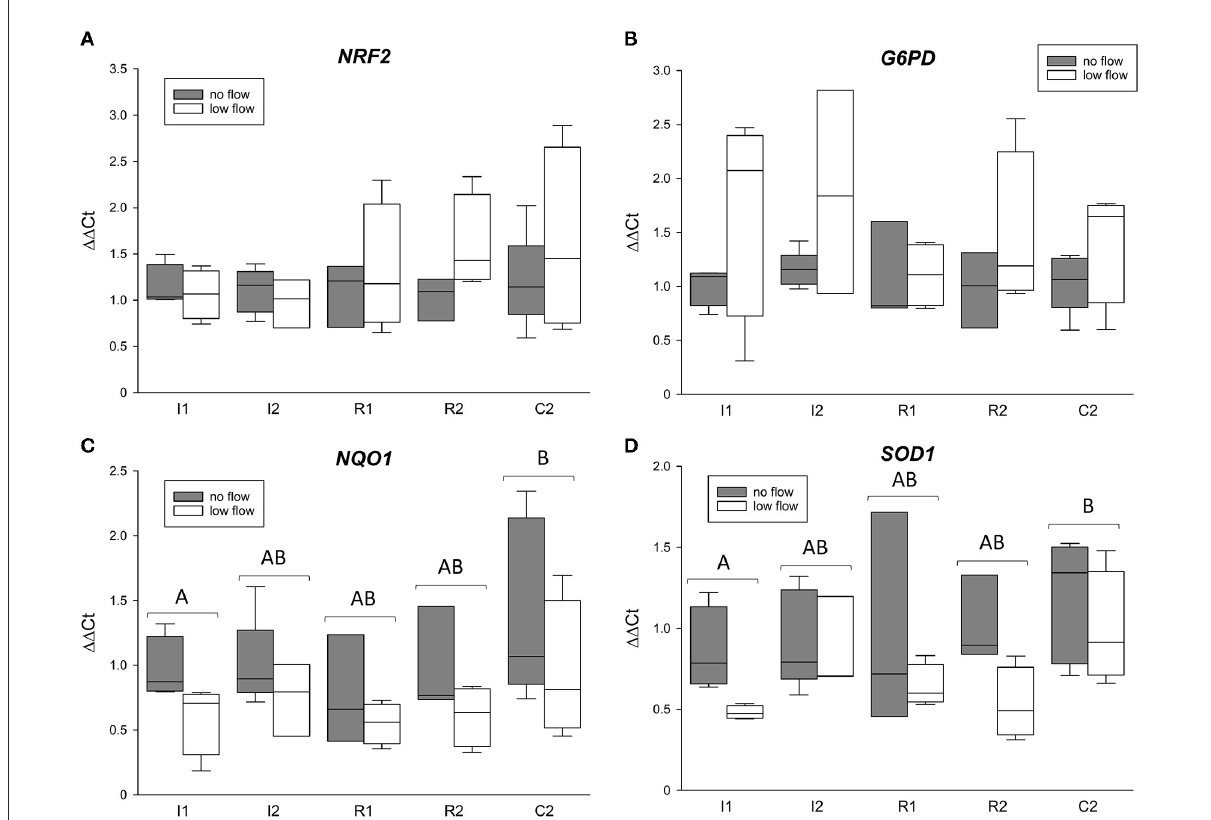
FIGURE2 mRNA expression of NRF2 (A) and its target genes G6PD (B) , NQO1 (C) , and SOD1 (D) . The gene expression is expressed relative to control tissue before the onset of ischemia (C1 = 1). Different letters indicate significant differences between the time points irrespective of the ischemia model ( p < 0.05, two-way RM ANOVA with post-hoc Holm-Sidak test). Boxes and error bars show the median, 10th, 25th, 75th, and 90th percentiles (no flow: gray; low flow: white); N = 5 (no flow) or 4 (low